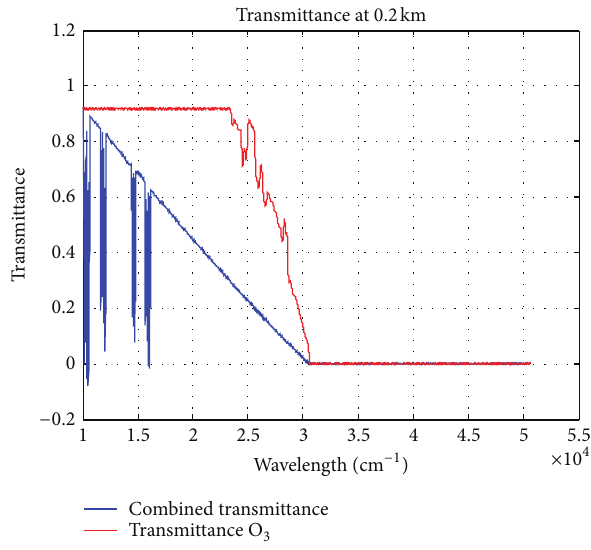
Figure 1: The analysis of variation between atmospheric transmit- tance and O 3 transmittance.